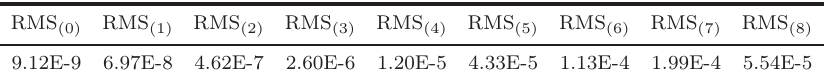
Table 6. Root-mean-square errors for example 3. Note:RMS ( i ) denote the root-mean square error of y ( i ) ,i = 0 , 1 , 2 ,..., 8 .